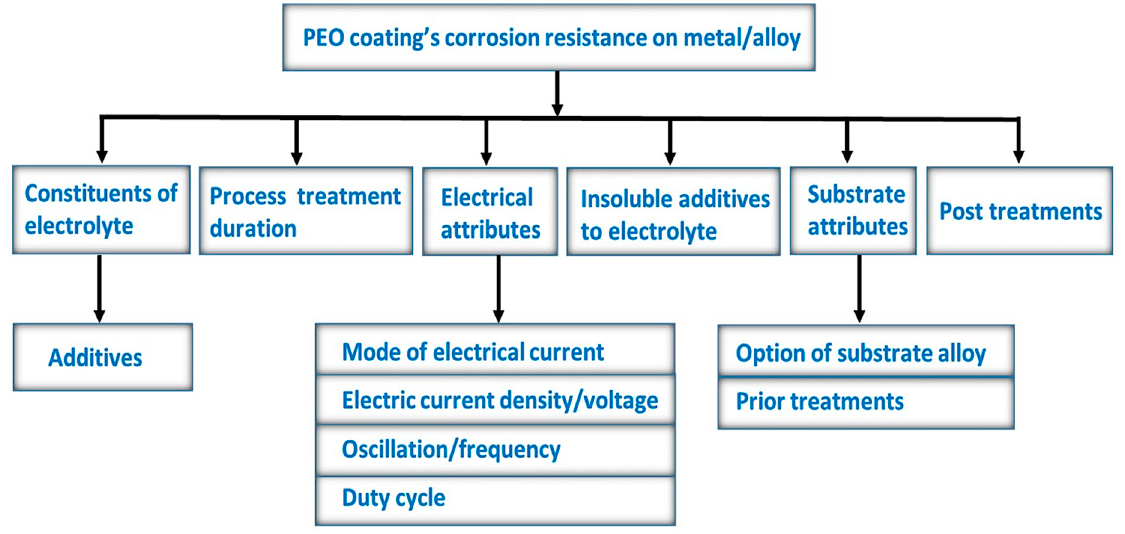
Figure 5. Processing conditions in corrosion resistance of PEO coatings. Adapted from [39].